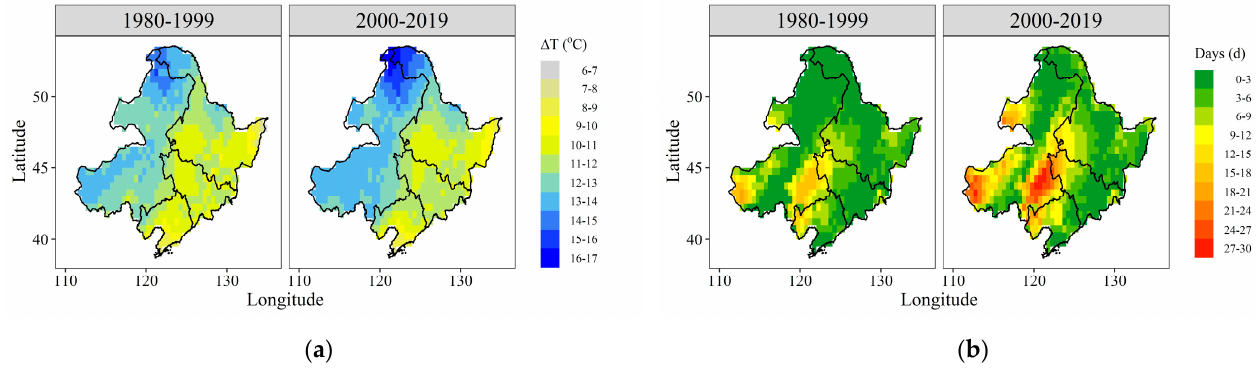
Figure A2. Change of diurnal thermal range ( ∆ T, ( a )) and heat stress days ( b ) during frost-free stage in the Northeast China Plain from 1980 to 2019.